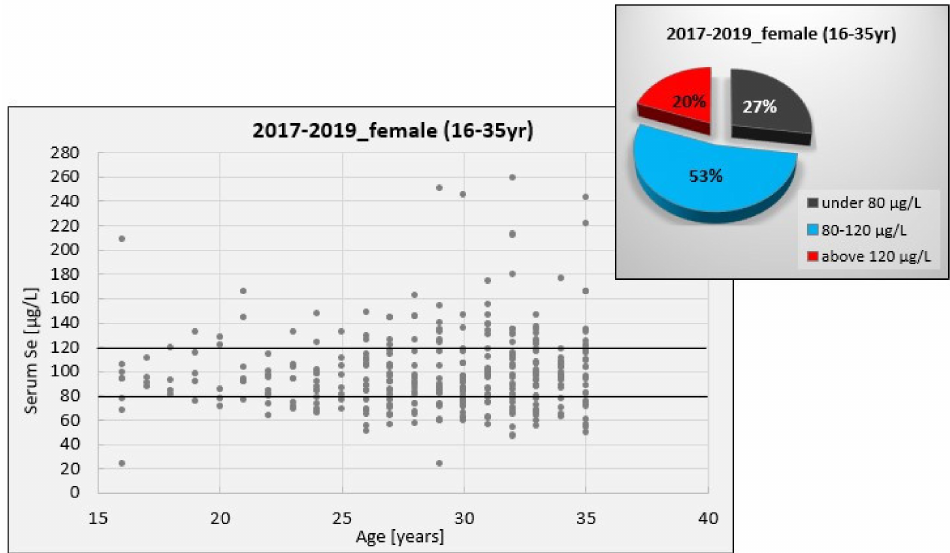
Figure 6. Distribution of SeS values in the young female population compared to the reference range of 80–120 µ g/L.